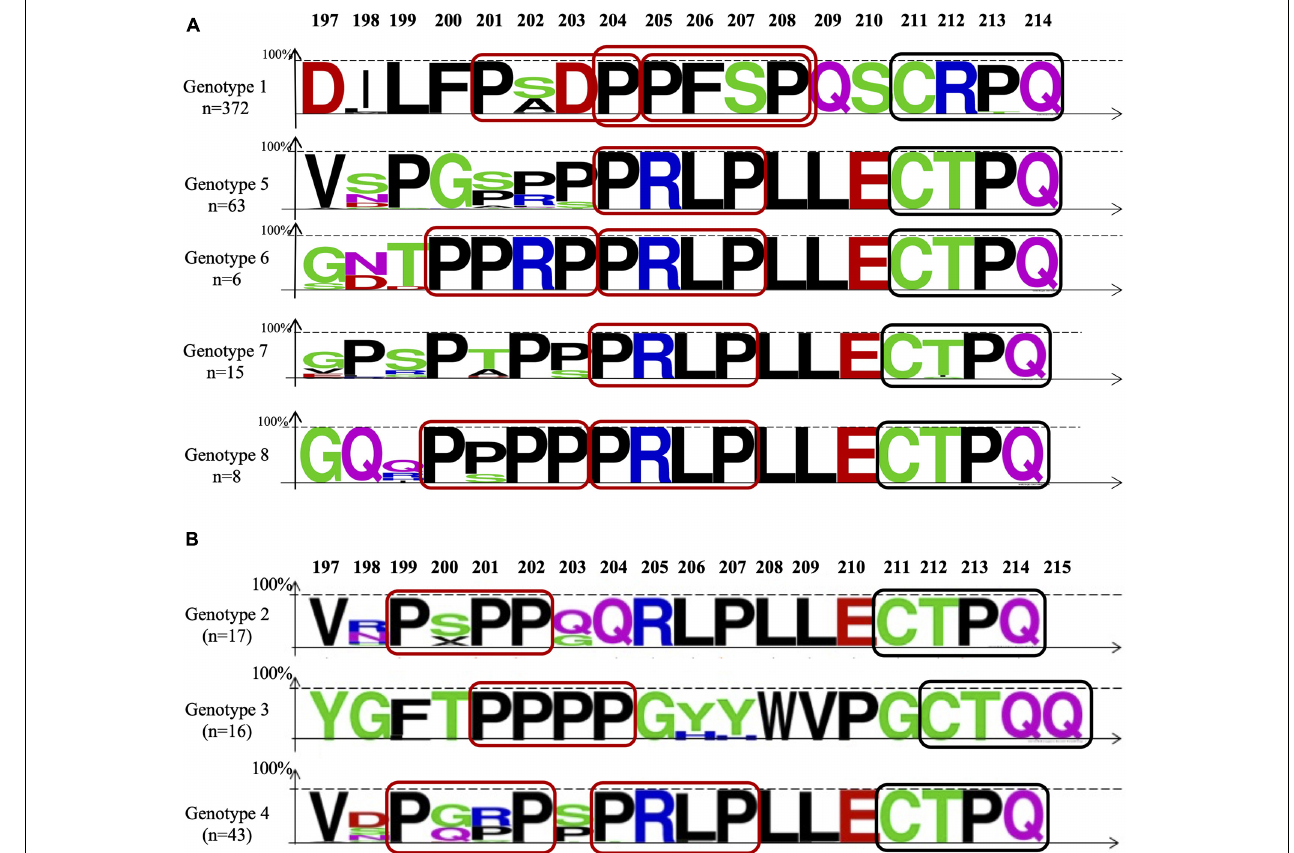
FIGURE 4 | Alignment of the delta packaging domain within the 19 C-terminal amino acids of the large delta protein (L-HDAg) using the Web Logo representation. The colors correspond to the physico-chemical properties of the amino acids: polar amino acids G, S, T, Y, and C (green); negatively charged amino acids Q and N (purple); basic amino acids K, R, and H (blue); acidic amino acids D and E (red); and hydrophobic amino acids A, V, L, I, P, W, F, and M (black). (A) The studied samples and (B) of HDV-2, -3, and -4 sequences retrieved from international reference database. On the top of the figure: Aa position. On the left, the number (n) of sequences aligned for each genotype group. The red boxes delimitate the PXXP motifs and the PPXXP, and the black ones the farnesylation